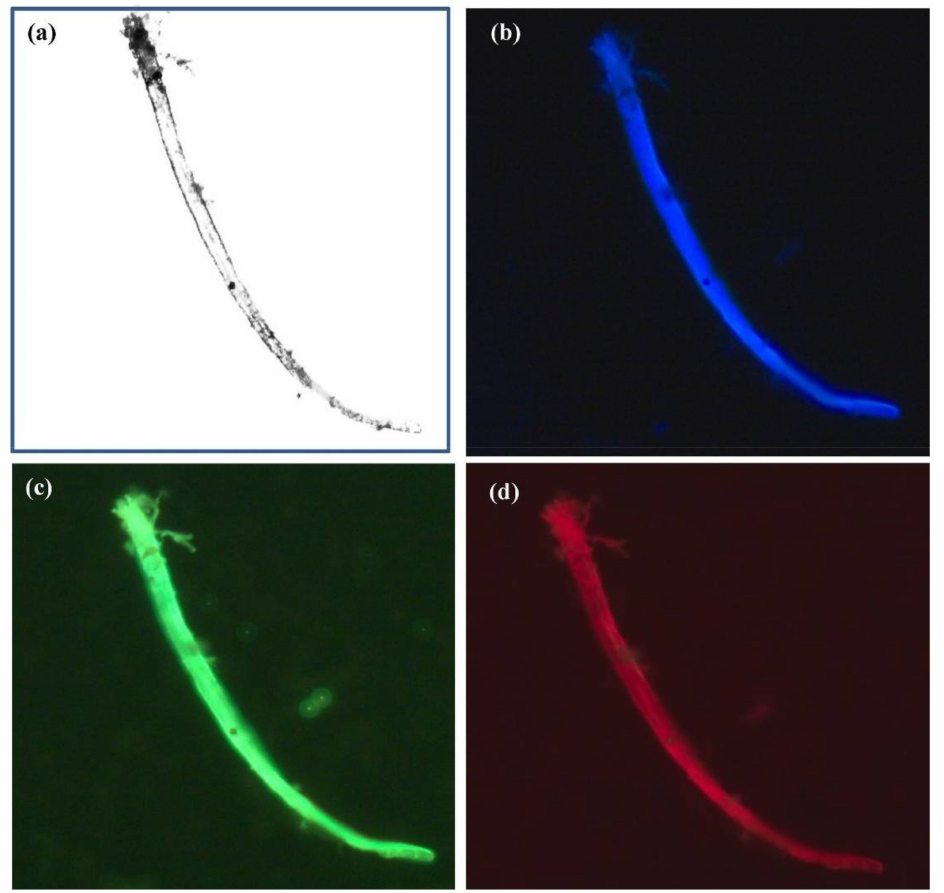
Figure 5. Fluorescence microscopic images of fungal cells ( Alternaria sp.) treated with chicken egg white-L-Cysteine-encapsulated Zn-undoped Ag nanoclusters. Image ( a ) without chicken egg white-L-Cysteine-encapsulated Zn-doped Ag nanoclusters and images with chicken egg white-L-Cysteine-encapsulated Zn-undoped Ag nanoclusters upon the laser excitation at ( b ) 405 nm (blue), ( c ) 488 nm (green), and ( d ) 561 nm (red), respectively. The concentration of chicken egg white-L-Cys-encapsulated Zn-undoped Ag nanoclusters was 0.5 µ g / mL